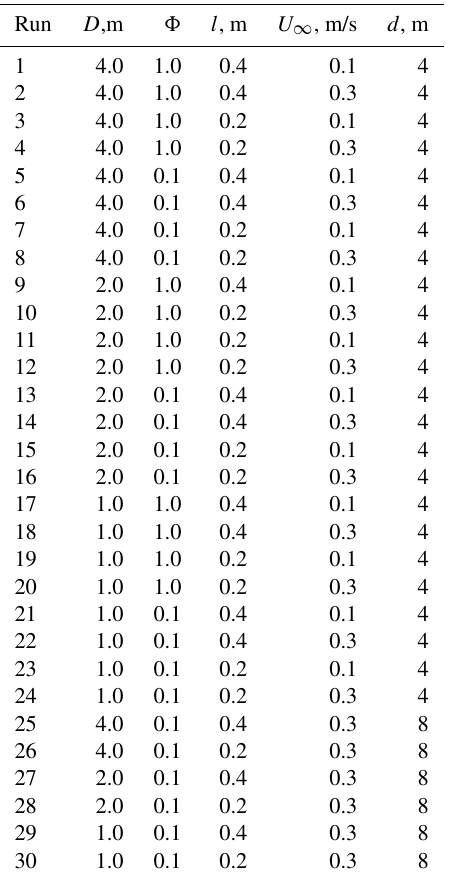
Table 1. Parameters and variables in the experimental